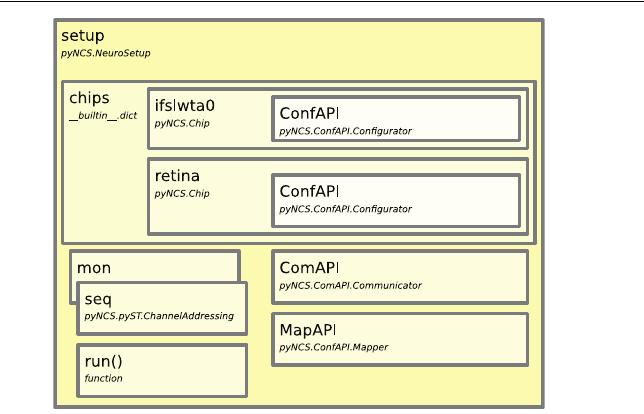
FIGURE 1 | Overview of PyNCS. Left: The “Setup description” and “Chip description” blocks represent XML files that provide the specifications of the hardware. A user-written Python script describes the neural network model and interacts with PyNCS to send data to and gather data from the system. Communication with the low-level drivers and the neuromorphic hardware is mediated by the communication and configuration API modules. These modules implement the interaction with the custom drivers, which can take the form of executables or code libraries. The arrows represent the data flow in the system. Right: The main components of the Setup class. The setup